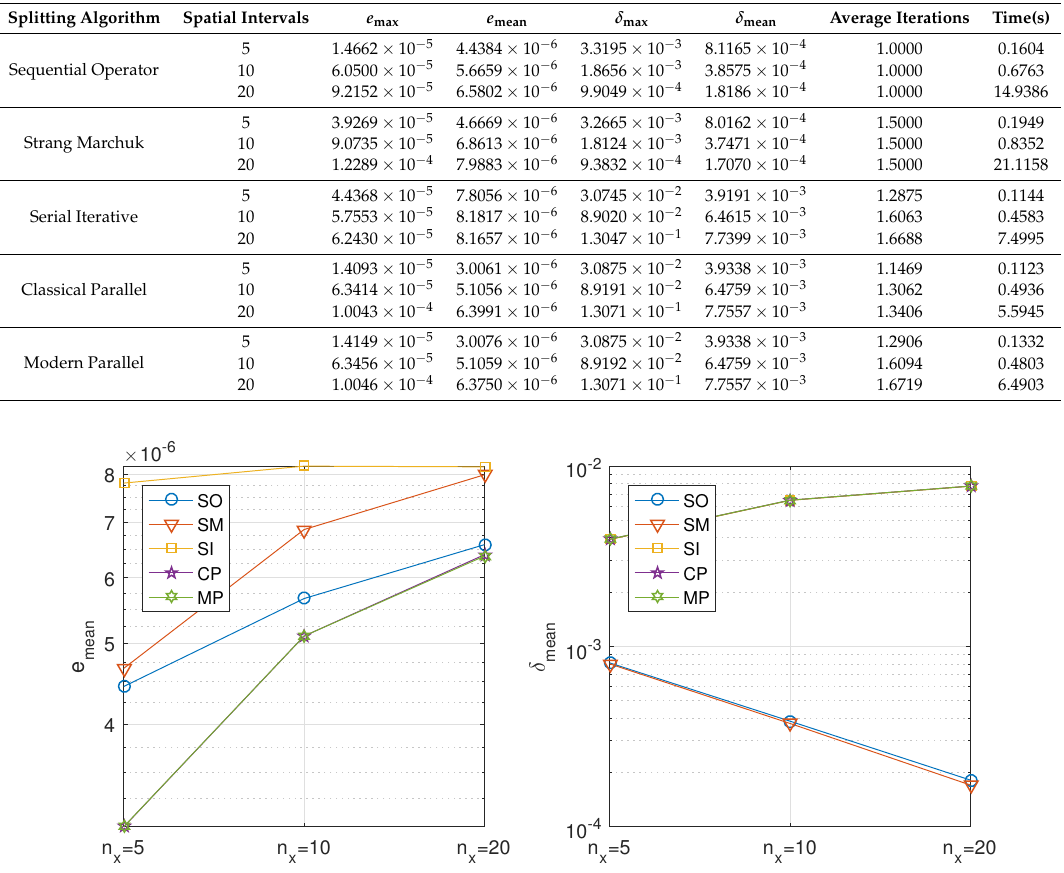
Table 20. Fractional diffusion equation. Results for the balanced decomposition with 320 time steps and different number of spatial subintervals.